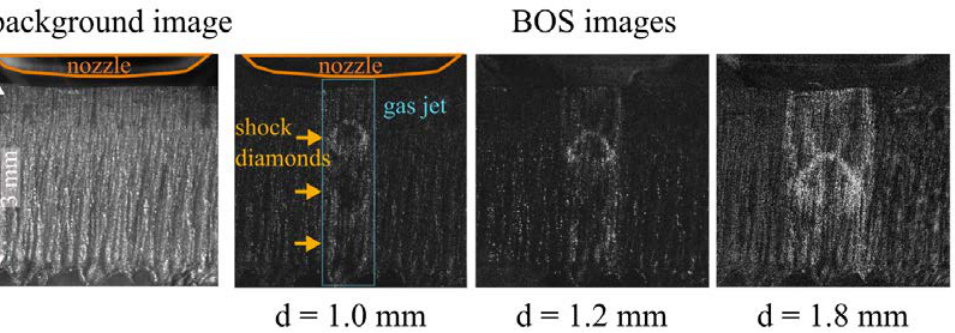
Figure 6. Background image of the striation pattern of a cut metal sheet; BOS images of the gas jets from three cutting nozzles with different opening diameters (d = 1.0 mm, d = 1.2 mm, and d = 1.8 mm). Illumination time: t = 1 µs.